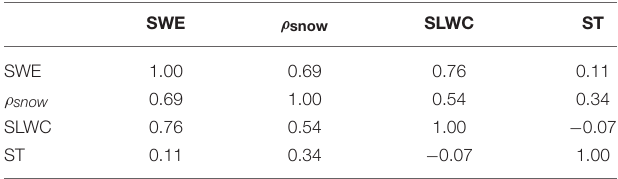
TABLE 4 | Cross-correlation matrix between Noah-MP simulated states for year 2004. SWE ρ snow SLWC